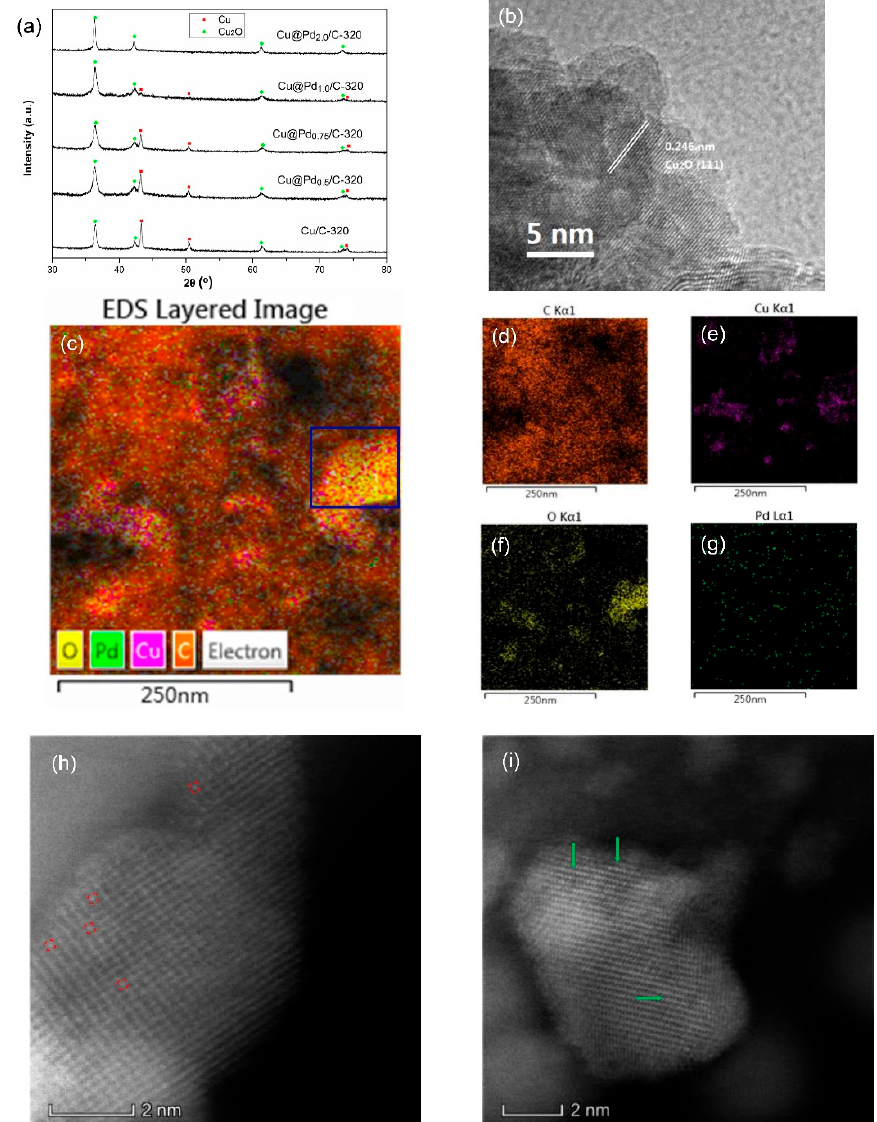
Figure 3. XRD patterns ( a ) of Cu@Pd / C-320, HRTEM ( b ), EDS mapping images ( c – g ), and high angular annular dark field scanning TEM (HAADF-STEM) images ( h , i ) of Cu@Pd 0.5 / C-320. The single Pd atoms (indicated by red circles) and Pd clusters (indicated by green arrows) could be seen in the HAADF-STEM images.